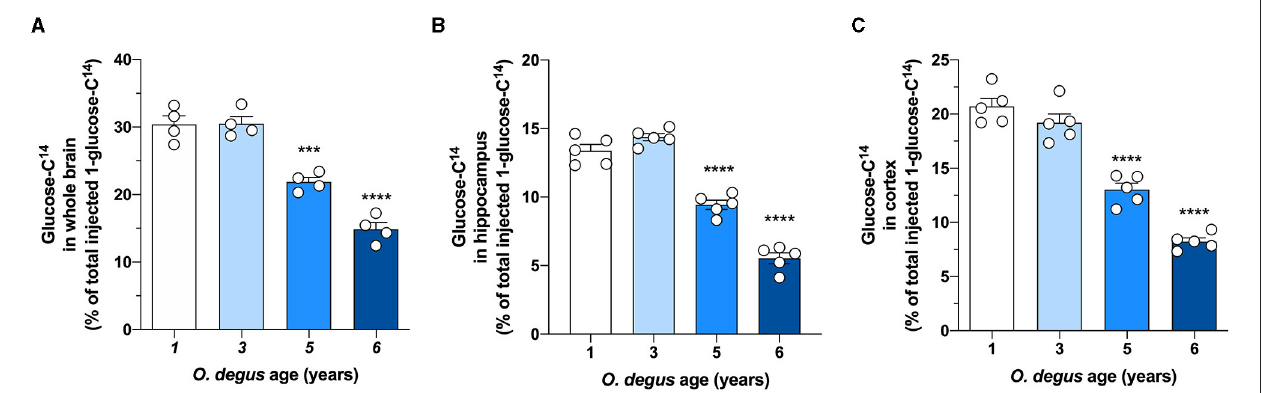
FIGURE 1 | The uptake of radioactive glucose in the whole brain, hippocampus, and cortex is reduced in aged degus. Radioactive glucose was injected via the tail vein, and 15min later, glucose uptake was measured in (A) the whole brain, (B) hippocampus, and (C) cortex in 1- (control), 3-, 5-, and 6-year-old degus. The data represent the mean ± SEM of 4–5 independent biological replicates in three technical replicates. Statistical significance: *** p < 0.001 and **** p < 0.0001, by one-way ANOVA, followed by Bonferroni’s post-hoc test.